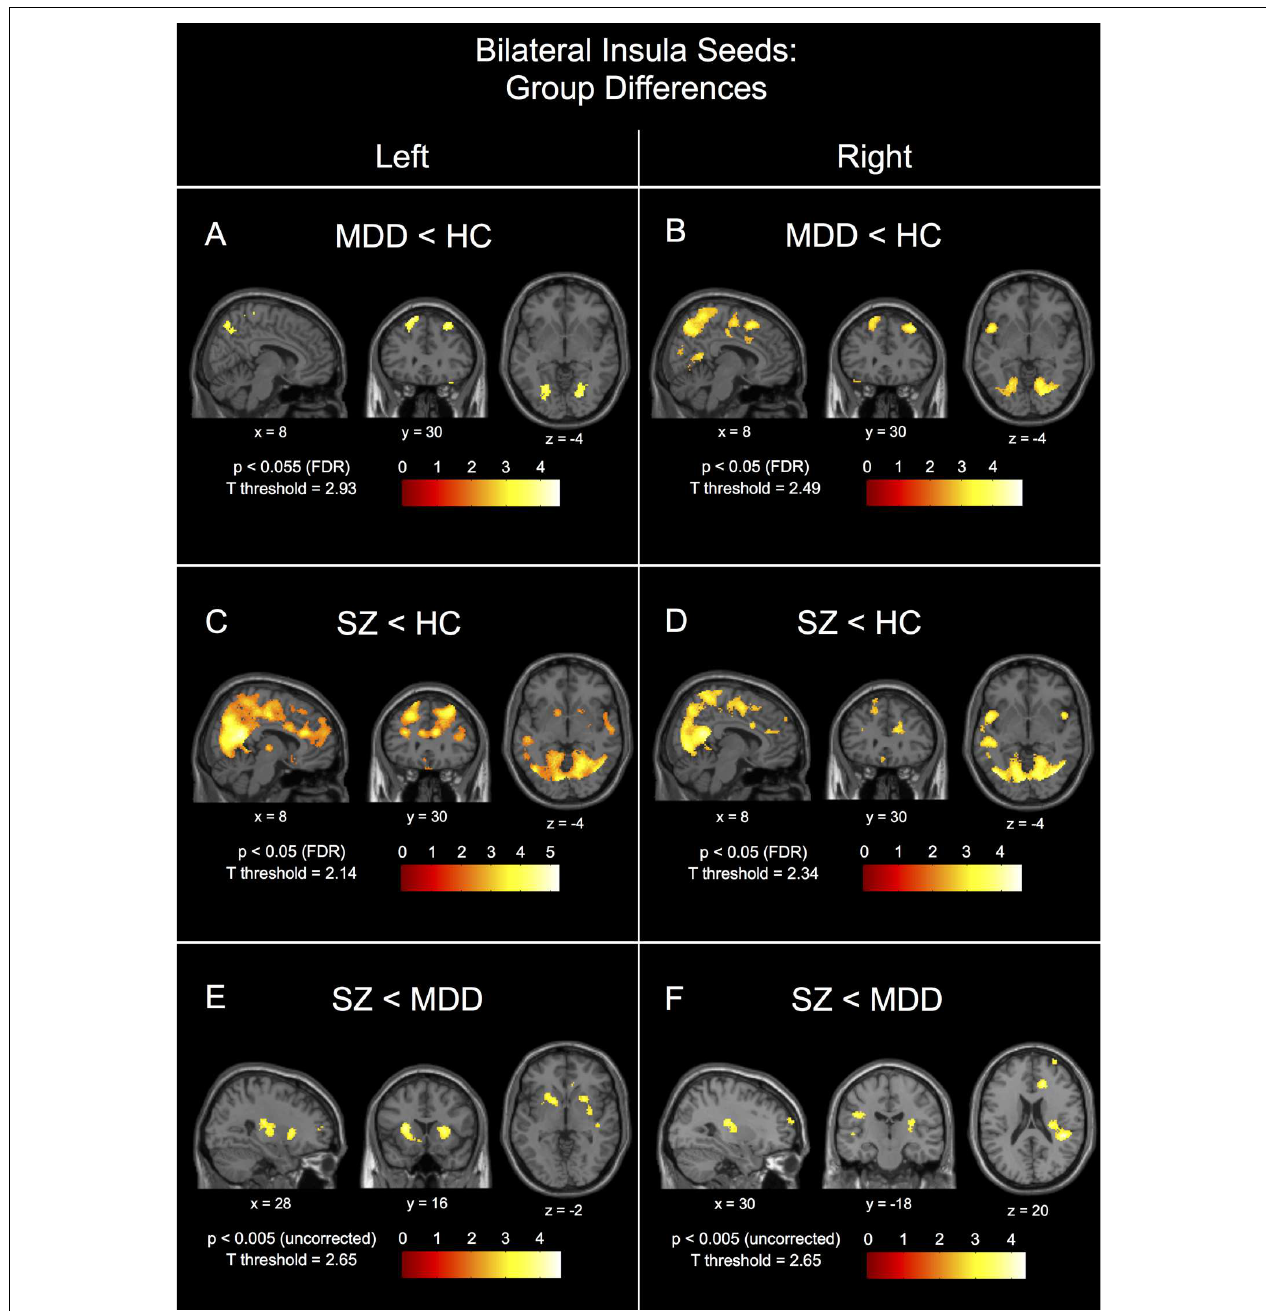
FIGURE 3 | Between-group connectivity differences for the bilateral insula seeds. Group differences are shown for the left insula seed for major depressive disorder patients (MDD) < healthy controls (HC) in (A) , schizophrenic patients (SZ) < HC in (C) , and SZ < MDD in (E) . Group differences are shown for the right insula seed for MDD < HC in (B) , SZ < HC in (D) , and SZ < MDD in (F) . Each image is labeled with its MNI coordinate. All p -value thresholds were set for display purposes only.